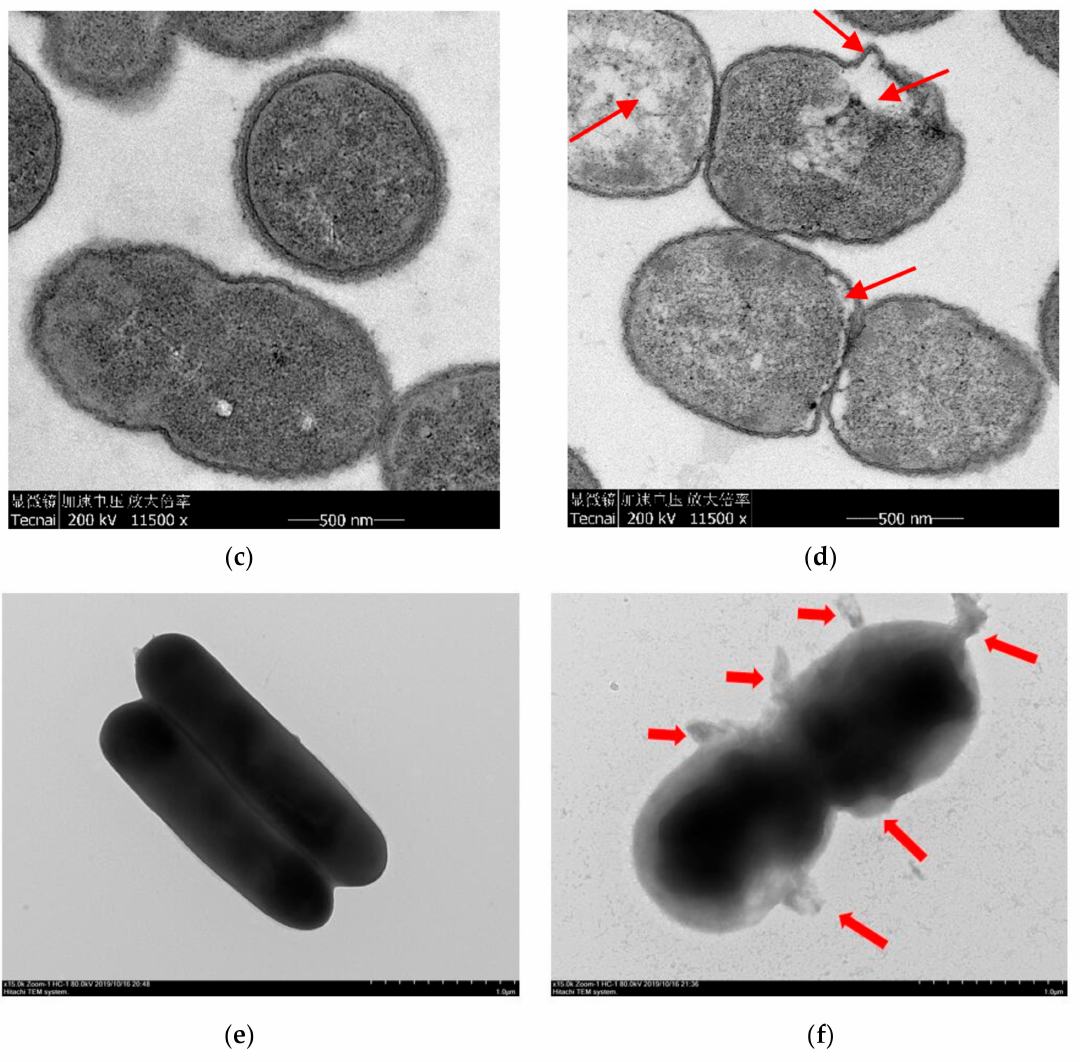
Figure 4. SEM pictures of A. johnsonii in ( a ) C group and ( b ) T group. TEM pictures of A. johnsonii in ( c ) C group and ( d ) T group. Negative staining pictures of A. johnsonii in ( e ) C group and ( f ) T